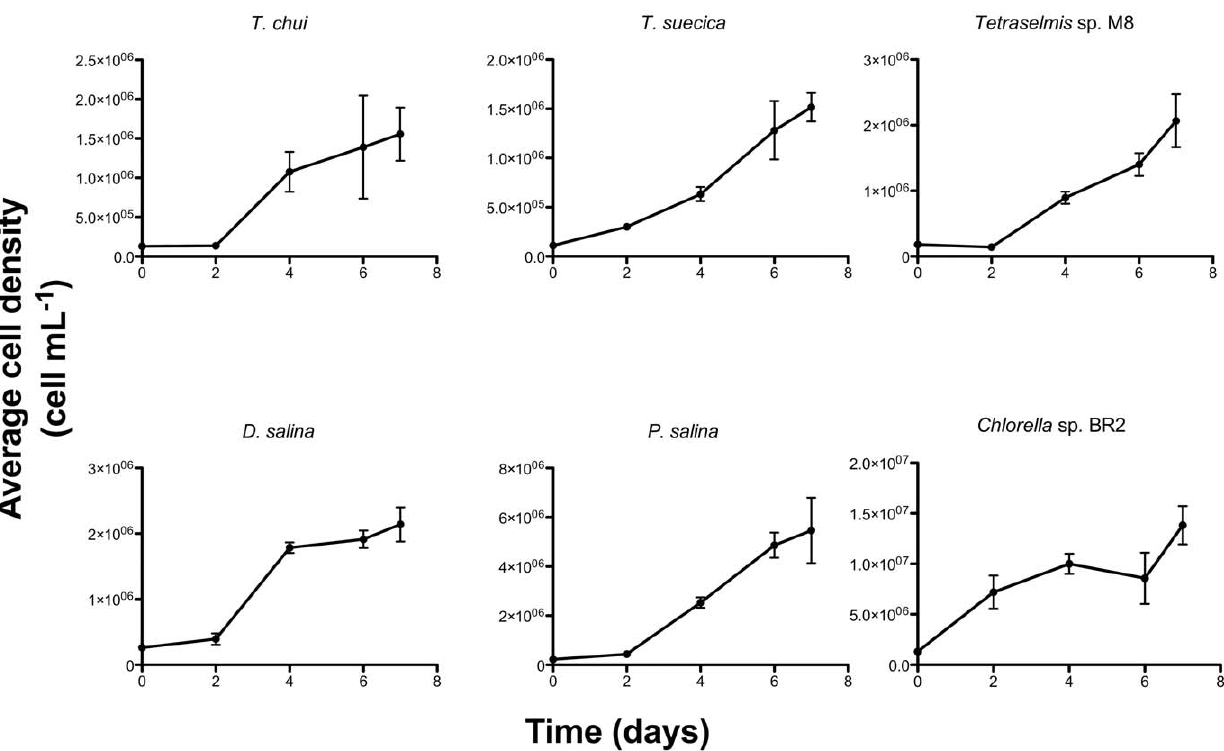
Figure 3. Growth curves of different microalgae in this study. T. chui , T. suecica , Tetraselmis sp. M8, D. salina , P. salina and Chlorella sp. BR2. Shown are average cell densities 6 SD from three biological replicates.